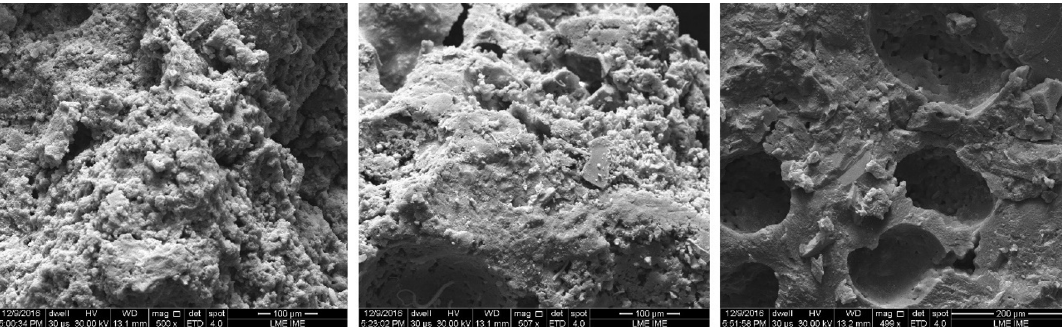
Figure 12. SEM electron micrographs of fracture of the PET/T-GCW composites: (a) 50/50 (b) 60/40 and (c)